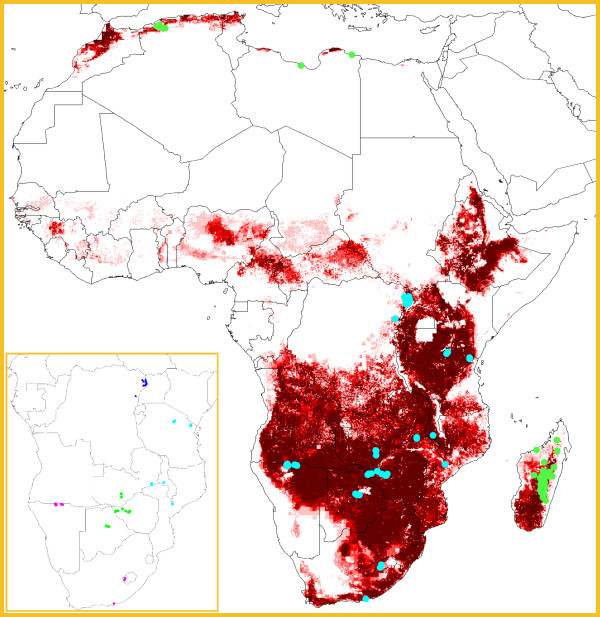
Geographic overview of plague in Africa. Inset: 45 occurrence points, colored differently to indicate the four regional subsets: subset A (dark blue triangles); subset B (light blue squares); subset C (green circles); subset D (pink diamonds). Sub-Saharan region shown in inset covers training region used for ENM development. Overall figure: projection of the ecological niche model based on all 45 occurrence locations from Sub-Saharan Africa. Dark shades indicate areas with greater model agreement in predicting areas as suitable for plague. Occurrence points in sub-Saharan Africa on which predictions were based, are shown in light blue; independent test points in Madagascar and North Africa are shown in green.